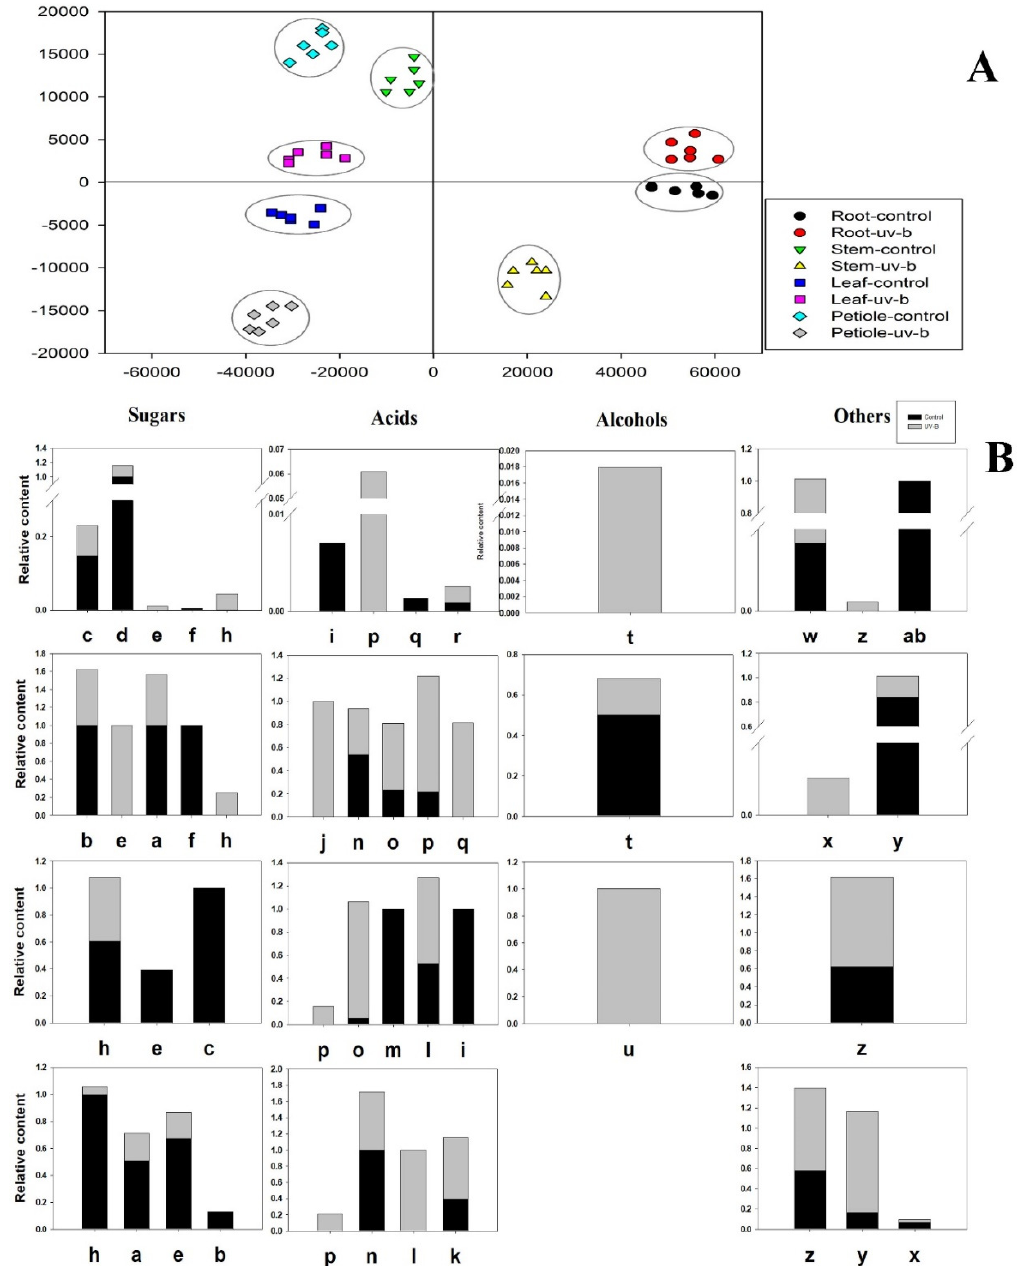
Figure 1. Metabolic analysis of specific tissues of A. mongholicus under control and UV-B treatments analyzed by GC-MS. ( A ) Partial least-squares discriminant analysis (PLS-DA); ( B ) The expression pattern of potential di ff erences. a , mannose; b , 3-mannobiose; c , fructose; d , talose; e , glucose; f , psicose; g , sorbofuranose; h , myo-inositol; i , 2,3,4-trihydroxybutyric acid; j , 4-aminobutyric acid; k , citric acid; l , hexonic acid; m , isothiocyanic acid; n , malic acid; o , oxalic acid; p , phosphonic acid; q , palmitic acid; r, propanedioic acid; s , stearic acid; t , pinitol; u , erythritol; w , d -glucopyranoside; x , 2- O -glycerol- d -galactopyranoside; y , methyl galactoside; z , glycerol; ab , dotriacontane; ac , 1-monopalmitin.